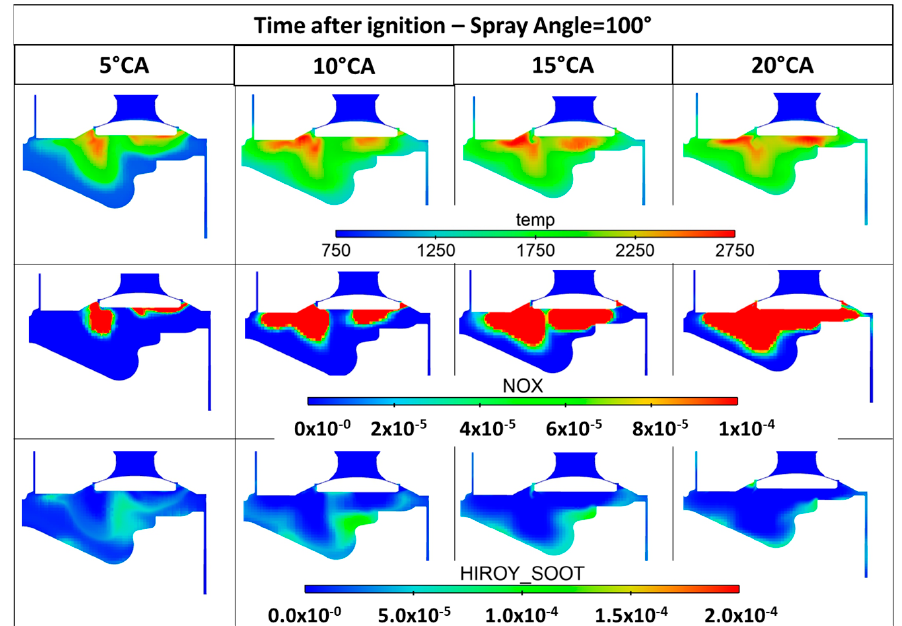
Figure 37. Evolution of in-cylinder temperature, NO x , and soot mass fraction contour plots in a plane formed by the cylinder axis and a spray axis at 5, 10, 15 and 20 °CA after SOIgn for an SIA of 100°.